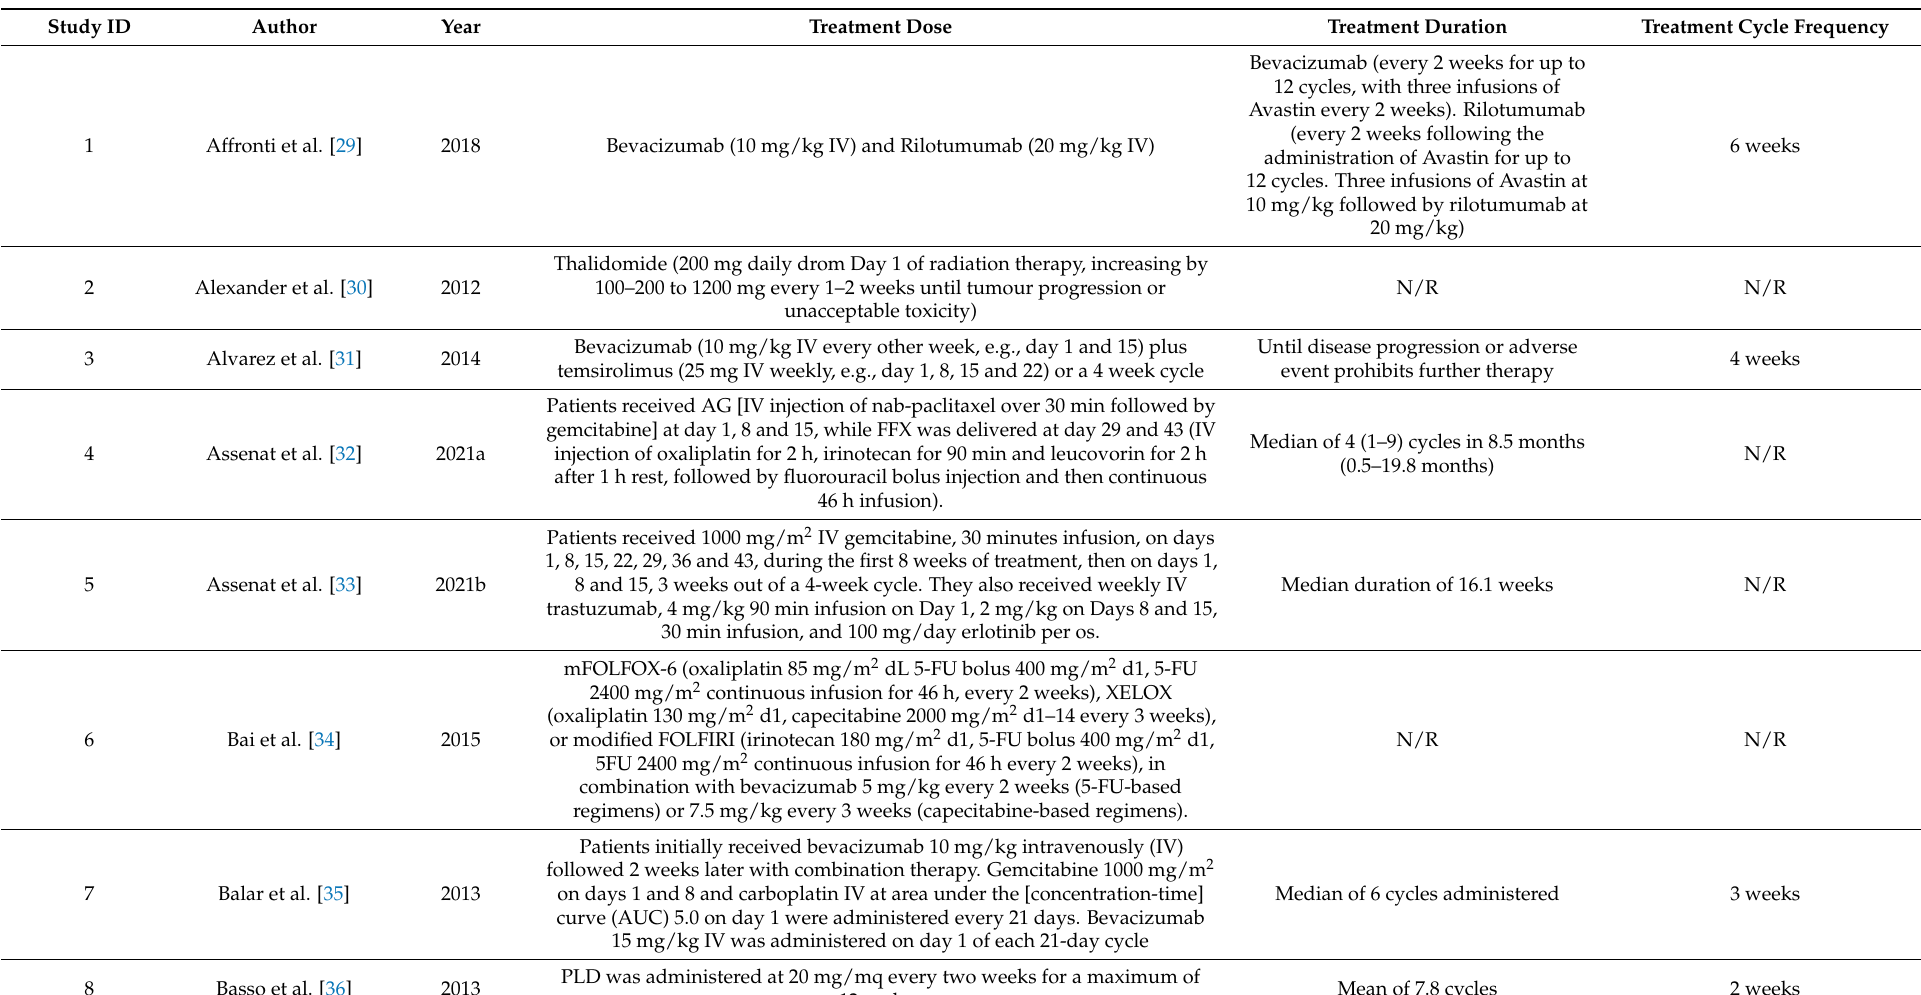
Table 3. Study characteristics stratified by frequency, dosage, and duration of treatment